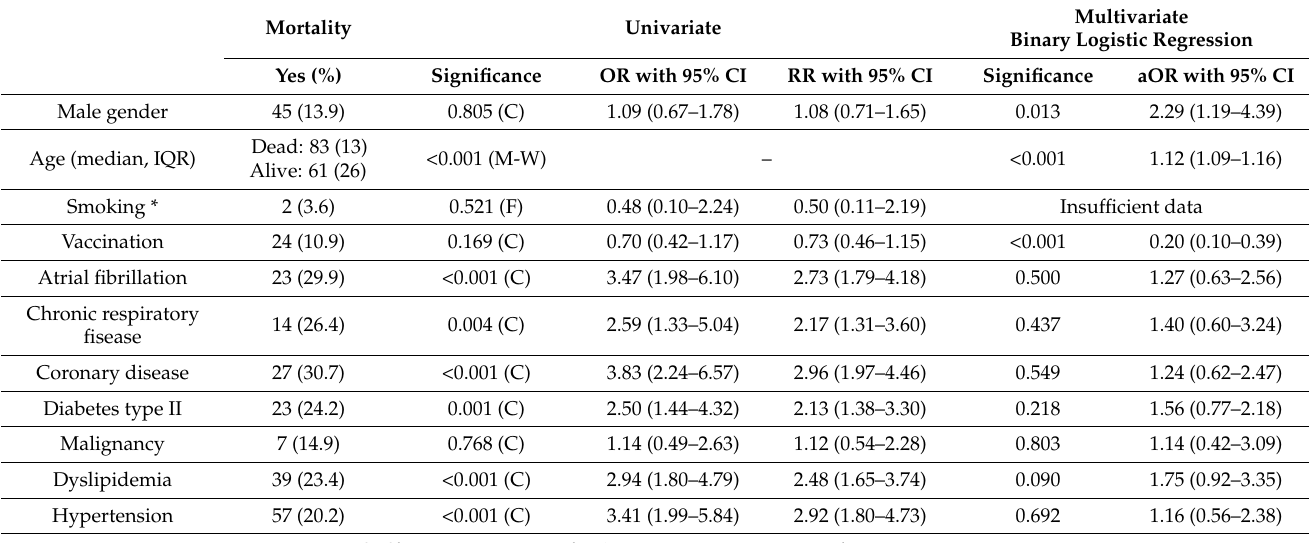
Table 1. Assessment of mortality risk due to COVID-19 by univariate and multivariate statistical analysis. Mortality Univariate